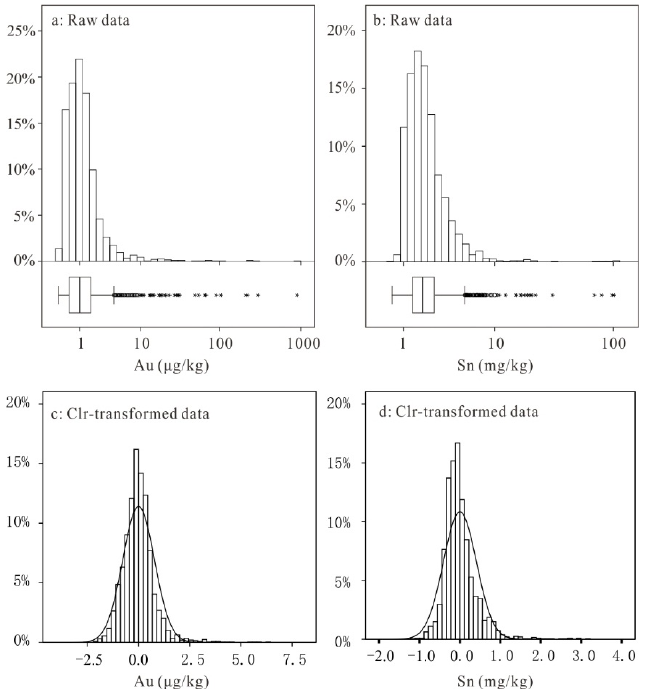
Figure 4. ( a ) Histogram and boxplot of Au on the raw data, ( b ) Histogram and boxplot of Sn on the raw data, ( c ) Histogram of Au on the clr-transformed data, ( d ) Histogram of Sn on the clr-transformed data. Asterisks indicate cases with values more than 1.5 times box length from the upper edge of the box.